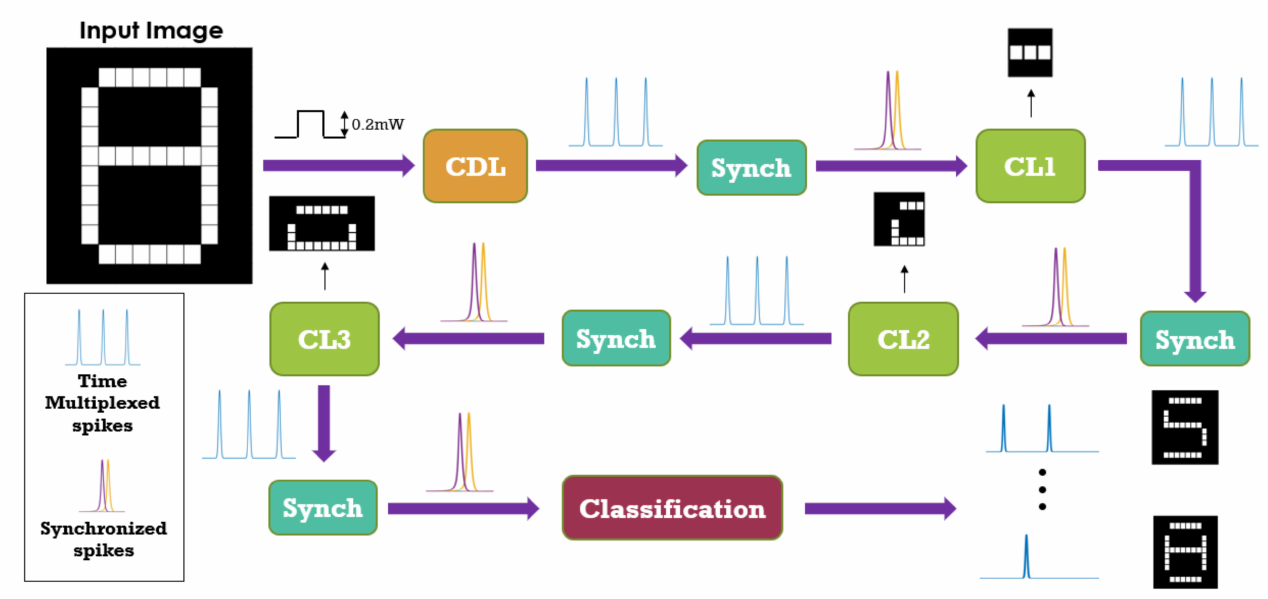
Figure 2. Photonic Spiking Convolutional Neural Network (PSCNN) architectural view. External electrical pulses according to the pixel’s intensity are inserted at the Contrast Detection Layer (CDL). White pixels are encoded as rectangular pulses with power of 0.2 mW whereas black pixels are encoded as rectangular pulses with power equal to 2 µ W. CDL’s output consists of spike trains with latency proportional to each pixel’s intensity. Different pixels are processed by the same neuron in a sequential function and output spikes are multiplexed in time. When CDL’s processing is complete then the output electrical spikes are inserted in the Synchronization Layer (Synch) in order to synchronize the spikes from different pixels and fit them to a specific time frame. After the synchronization is completed, spikes are inserted into the First Convolutional Layer (CL1) which detects spike patterns (features) according to their timing. When a pattern is detected the corresponding neuron of CL1 fires a spike (feature extraction). These new spikes originating from CL1 are transmitted to the Second Convolutional Layer (CL2) in order to detect more complex patterns. The same procedure is repeated in the Third Convolutional Layer (CL3). At the Classification Layer the network is able to classify the incoming image based on the detected patterns from all CL3. Throughout the network, synchronizing procedures are necessary in order for the spikes to coincide at the next